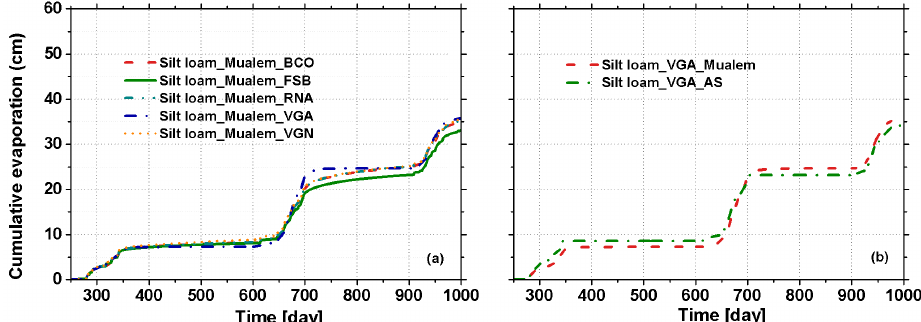
Figure 14. Cumulative evaporation from a silt loam profile for all parameterizations (see Table 1) with Mualem’s (1976) conductivity function (a) and the VGA parameterization with conductivity functions according to Mualem (1976) and Alexander and Skaggs (1986) (b) .